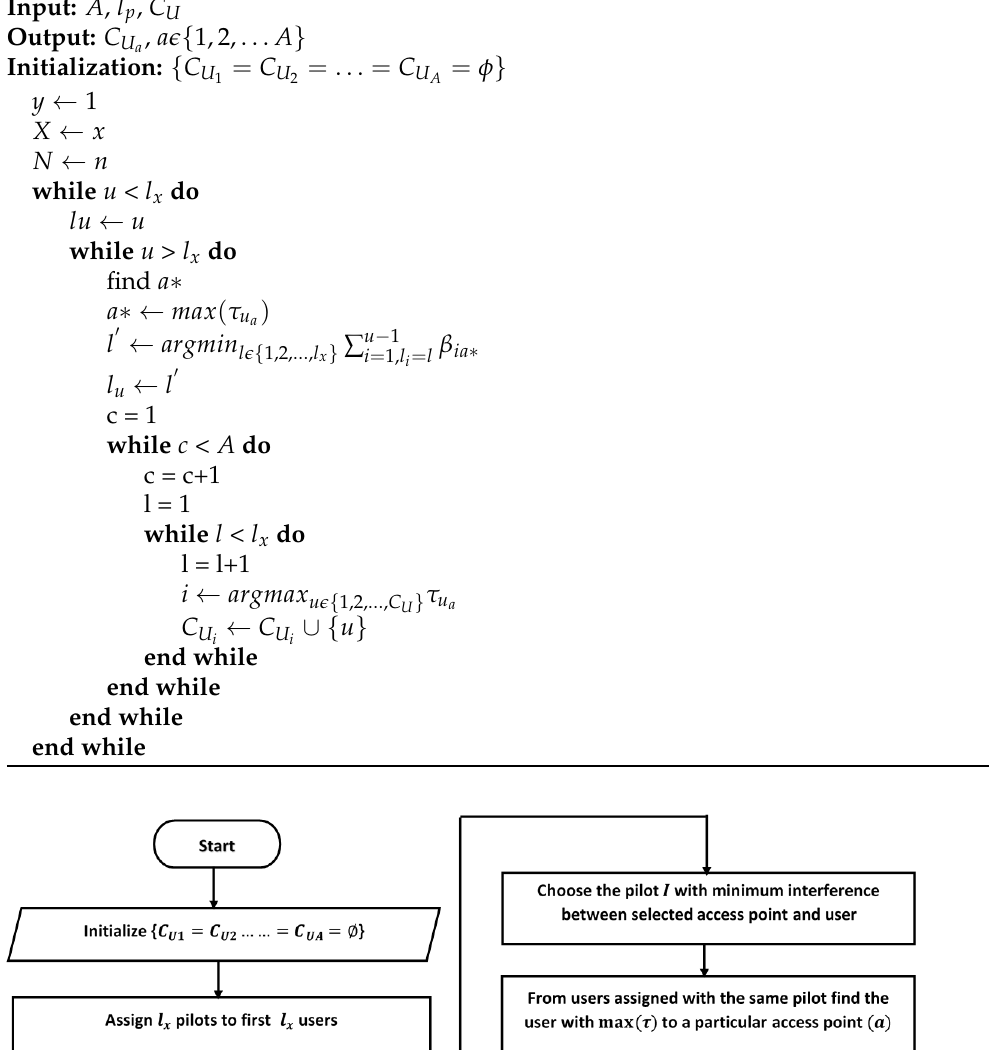
Algorithm 1 Weight-based user-scheduling algorithm.